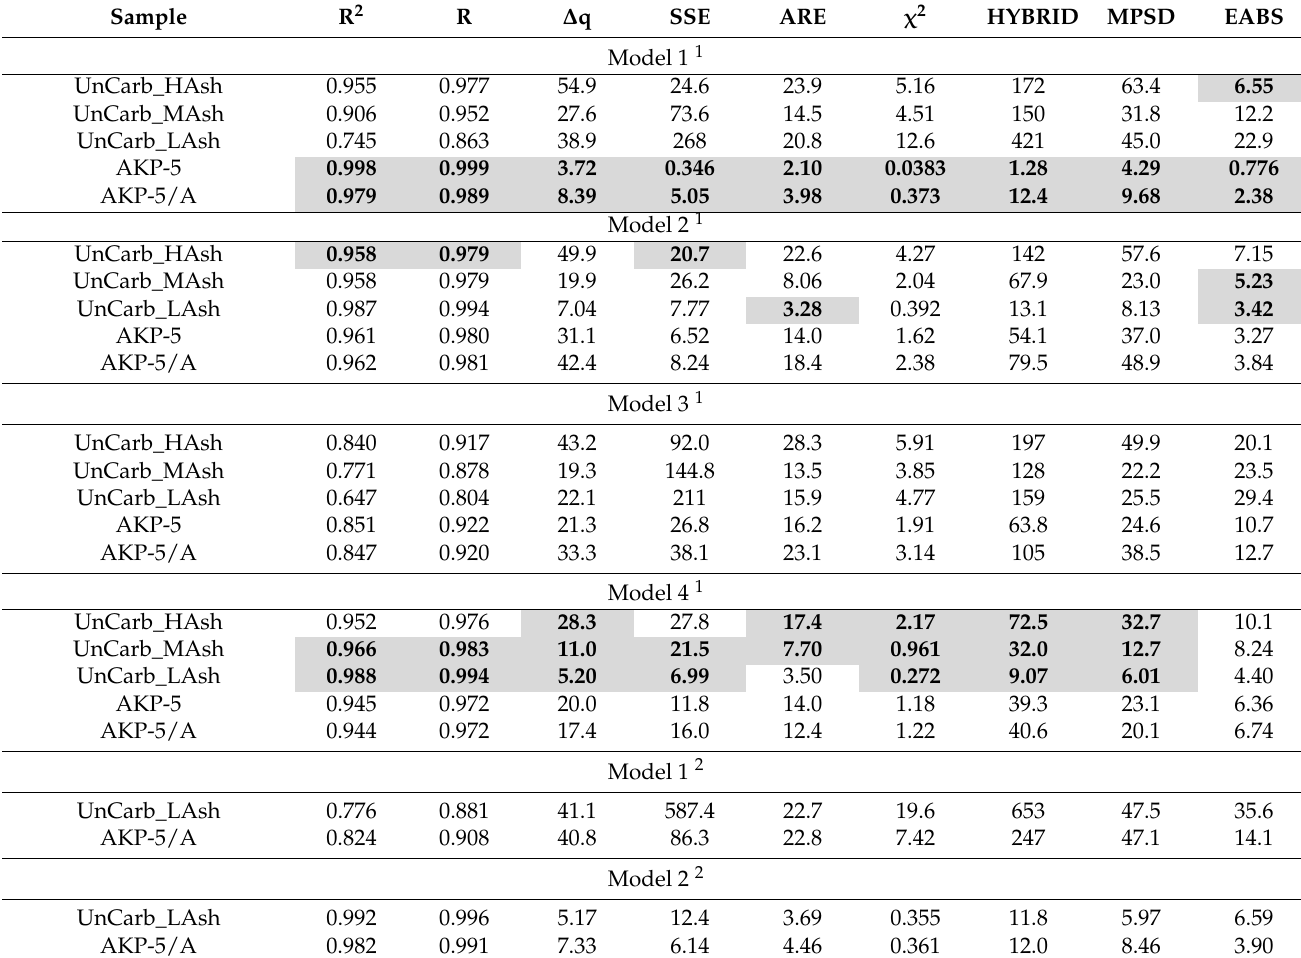
Table 3. Error analysis for kinetic models solved by linear regression